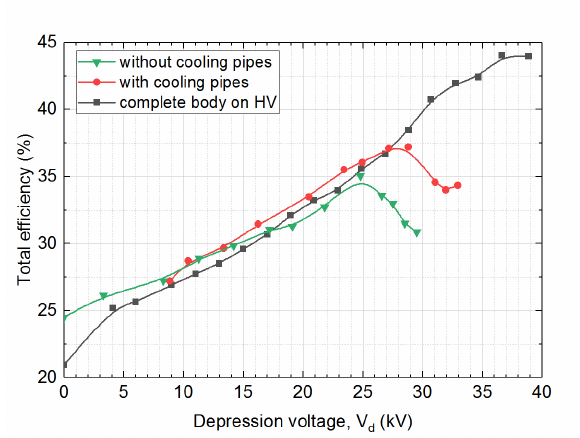
Fig. 5. Measured total efficiency (in depressed collector operation) with respect to the depression voltage for difference configurations of the SP prototype gyrotron (LVOP with average output power approximately 850